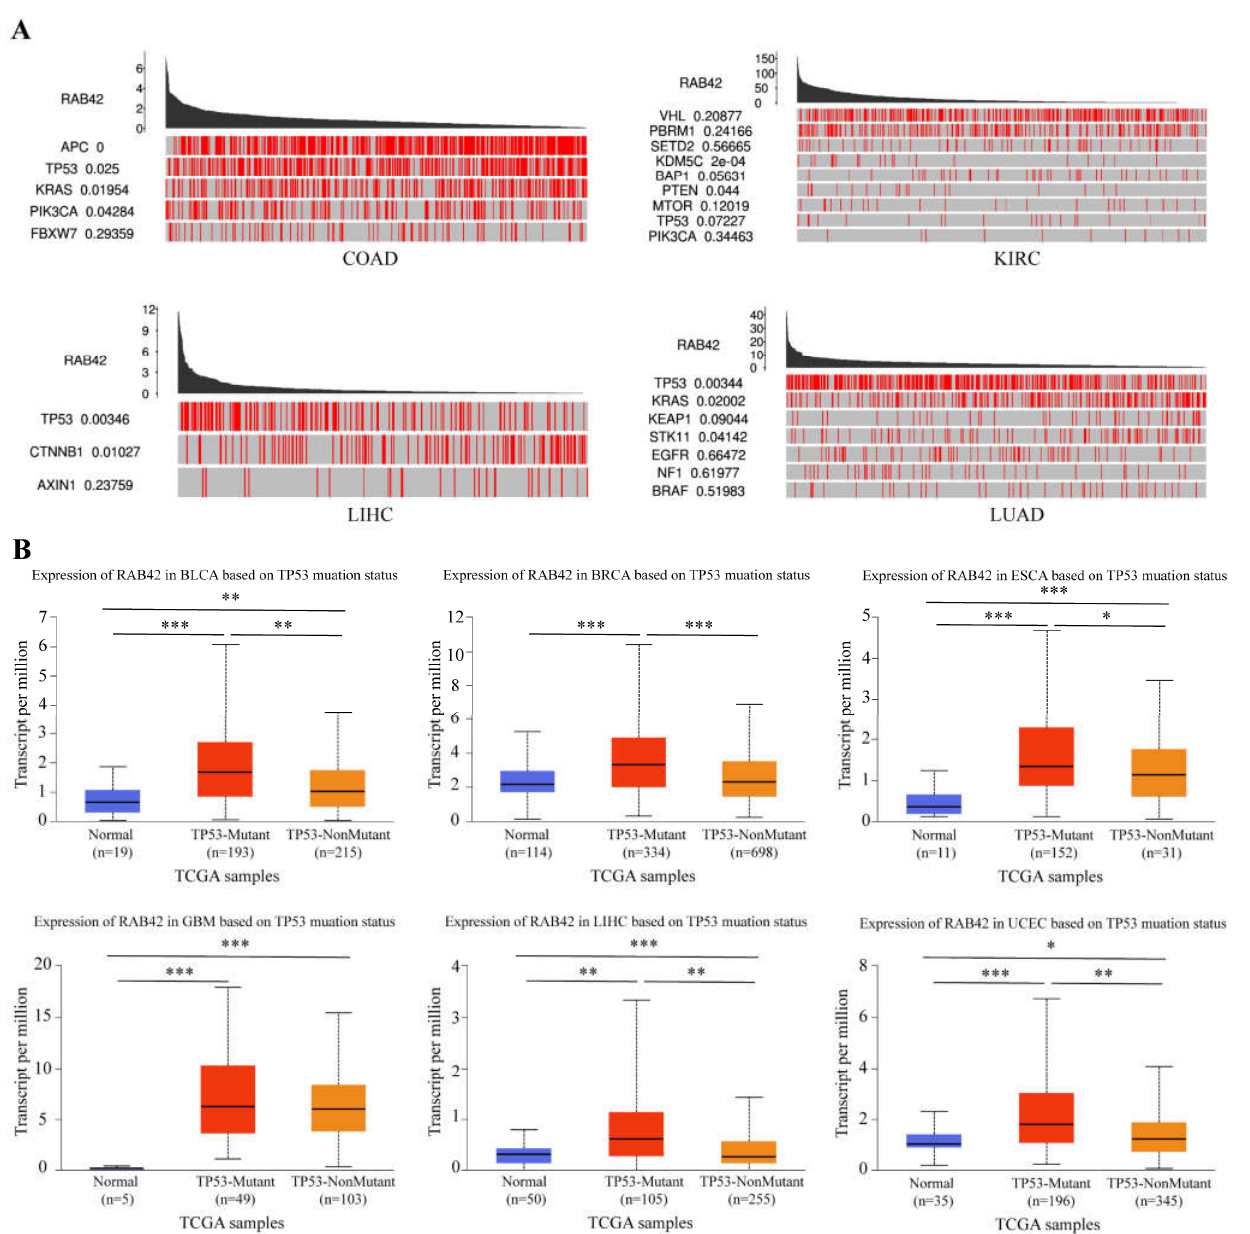
Figure 10. The effect of driver genes on RBA42 expression. ( A ) The correlation between driver genes and RAB42 expression using the TCGA Portal database. ( B ) The effect of TP53 mutation status on RAB42 expression using the UALCAN database. * p < 0.05, ** p < 0.01, and *** p < 0.001.